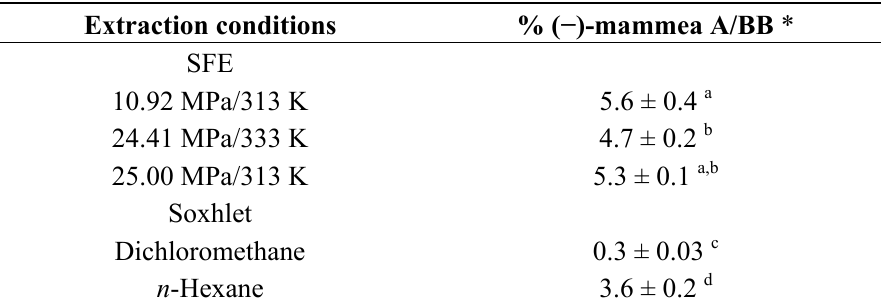
Table 2. Amount of the compound ( − )-mammea A/BB in Calophyllum brasiliense leaves extracts obtained by different extraction